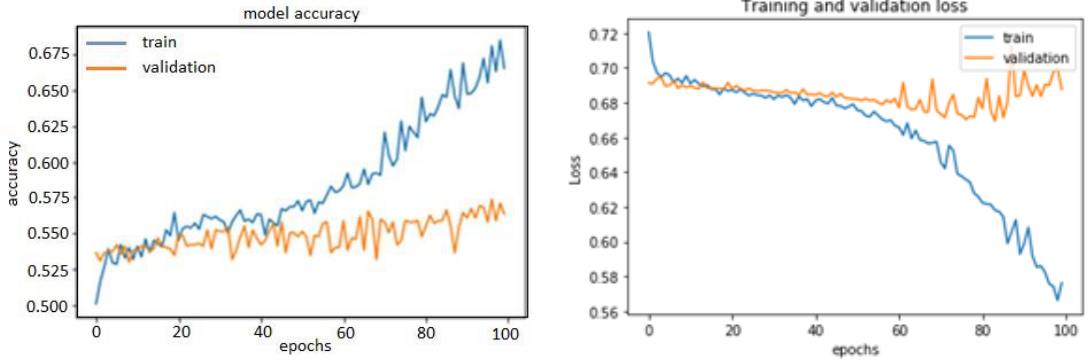
Figure 12. Accuracy and loss model of wavelet_1D-CNN.